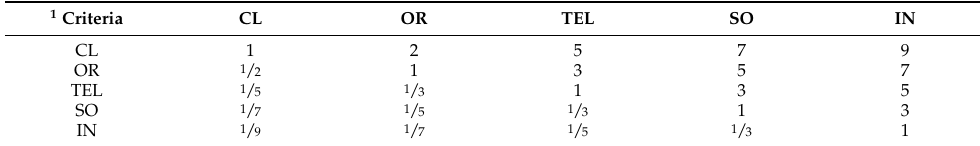
Table 7. Comparison matrix of the adopted decision criteria obtained from experts’ judgments. 1 Criteria CL OR TEL SO IN CL 1 2 5 7 9 OR 1 /